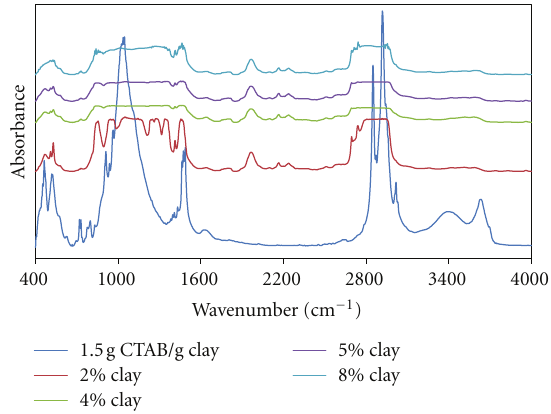
Figure 12: FTIR spectra of produced PEO/clay nanocomposites at various clay compositions (1.5g CTAB/g clay ratio).